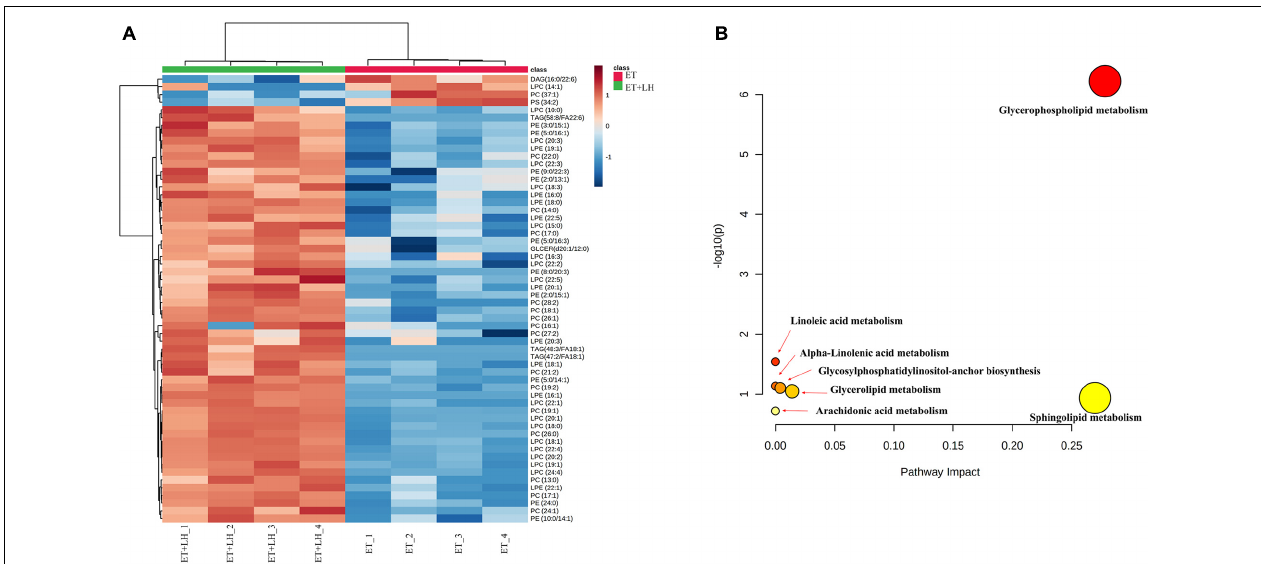
FIGURE 6 | Metabolic analysis of the hepatoprotective effect of Leonurine hydrochloride (LH). (A) Heatmaps of identified metabolites between ET and ET + LH with the description of treatments (ethanol-treated cells and those treated with alcohol and LH). The row Z-score or scaled expression value of each feature is plotted in red–blue color scale. Positive z-score (red) indicates a predicted up-regulated function and negative z-score (blue) is a down-regulated function. (B) Metabolic pathway analysis by MetaboAnalyst 5.0. Pathway impact value based on the pathway topology analysis. The x -axis represents the pathway impact value computed from pathway topological analysis, and the y -axis is the-log of the p -value obtained from pathway enrichment